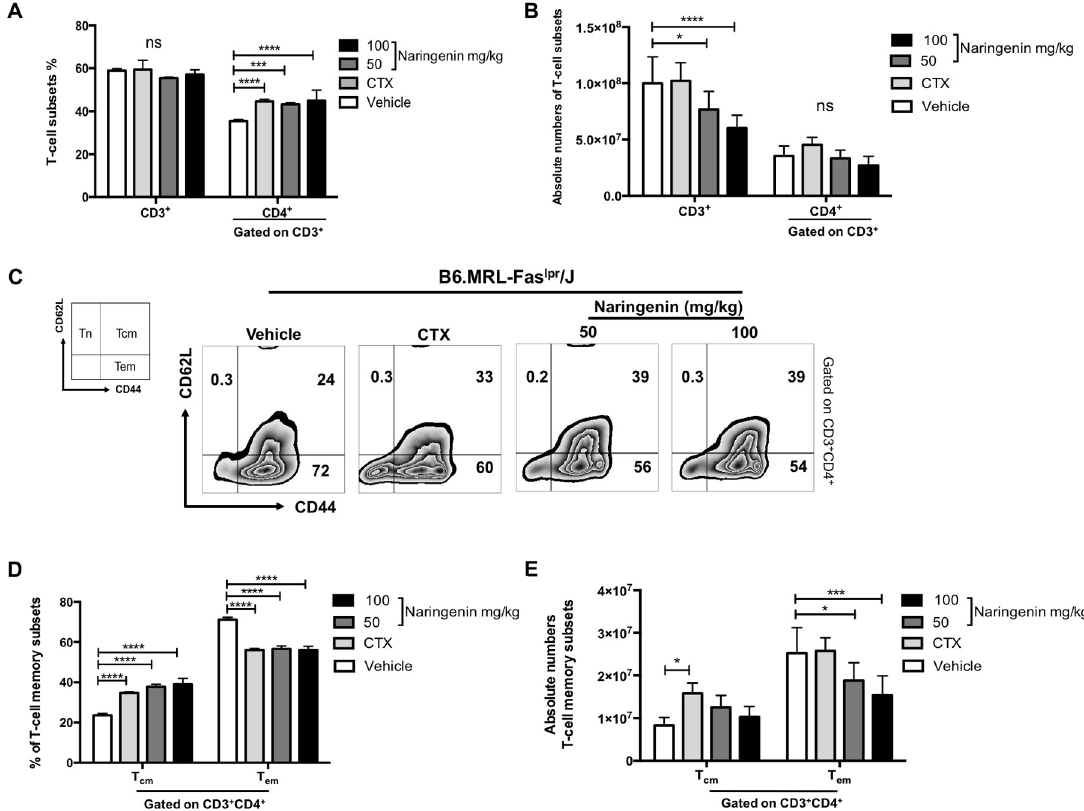
Fig 4. Naringenin treatment diminished splenic CD4 + CD44 hi CD62L - effector memory cells in B6.MRL-Fas lpr /J mice. Total splenic cells were stained with CD3-BV605, anti-CD4-PerCP-Cy5.5, anti-CD44-PE-Cy7 and anti-CD62L-APC. Cells were analyzed by flow cytometry. (A) Naringenin treatment reduced the percentages of CD4 + T cells. (B) By other hand, splenic absolute numbers of CD3 + T cells from mice under Naringenin treatment were significantly reduced. (C) Representative dot plots gated on CD3 + CD4 + cells showing the CD44 hi CD62L + T cm and CD44 hi CD62L - T em subsets. (D) Both Naringenin dose reduced the percentage of T em cells and diminished (E) the splenic absolute numbers of this T-cell subset. Statistical analysis was performed by one-way ANOVA followed by Tukey´s test. Each value is the mean ± SD, n � 5 mice. �� p � 0.01, ��� p � 0.001, ���� p � 0.0001 compared versus